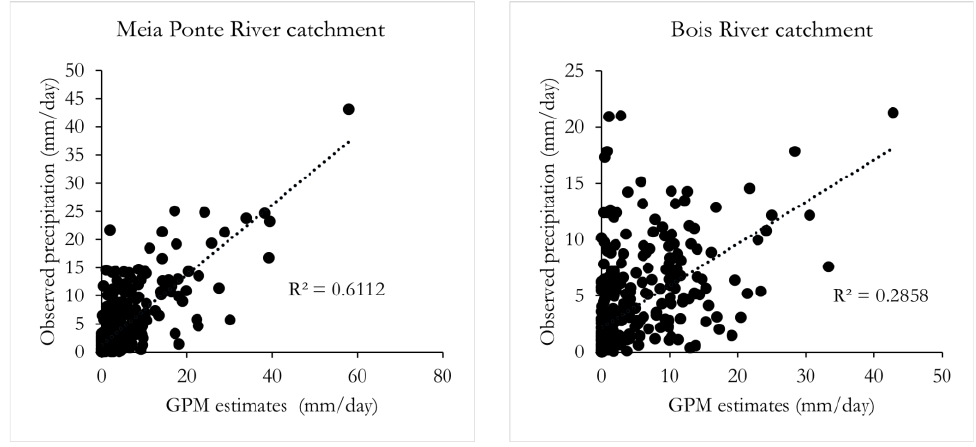
Figure 4. Scatterplots of the GPM estimates and the observed precipitation amounts for the Meia Ponte River catchment ( left panel) and the Bois River catchment ( right panel).